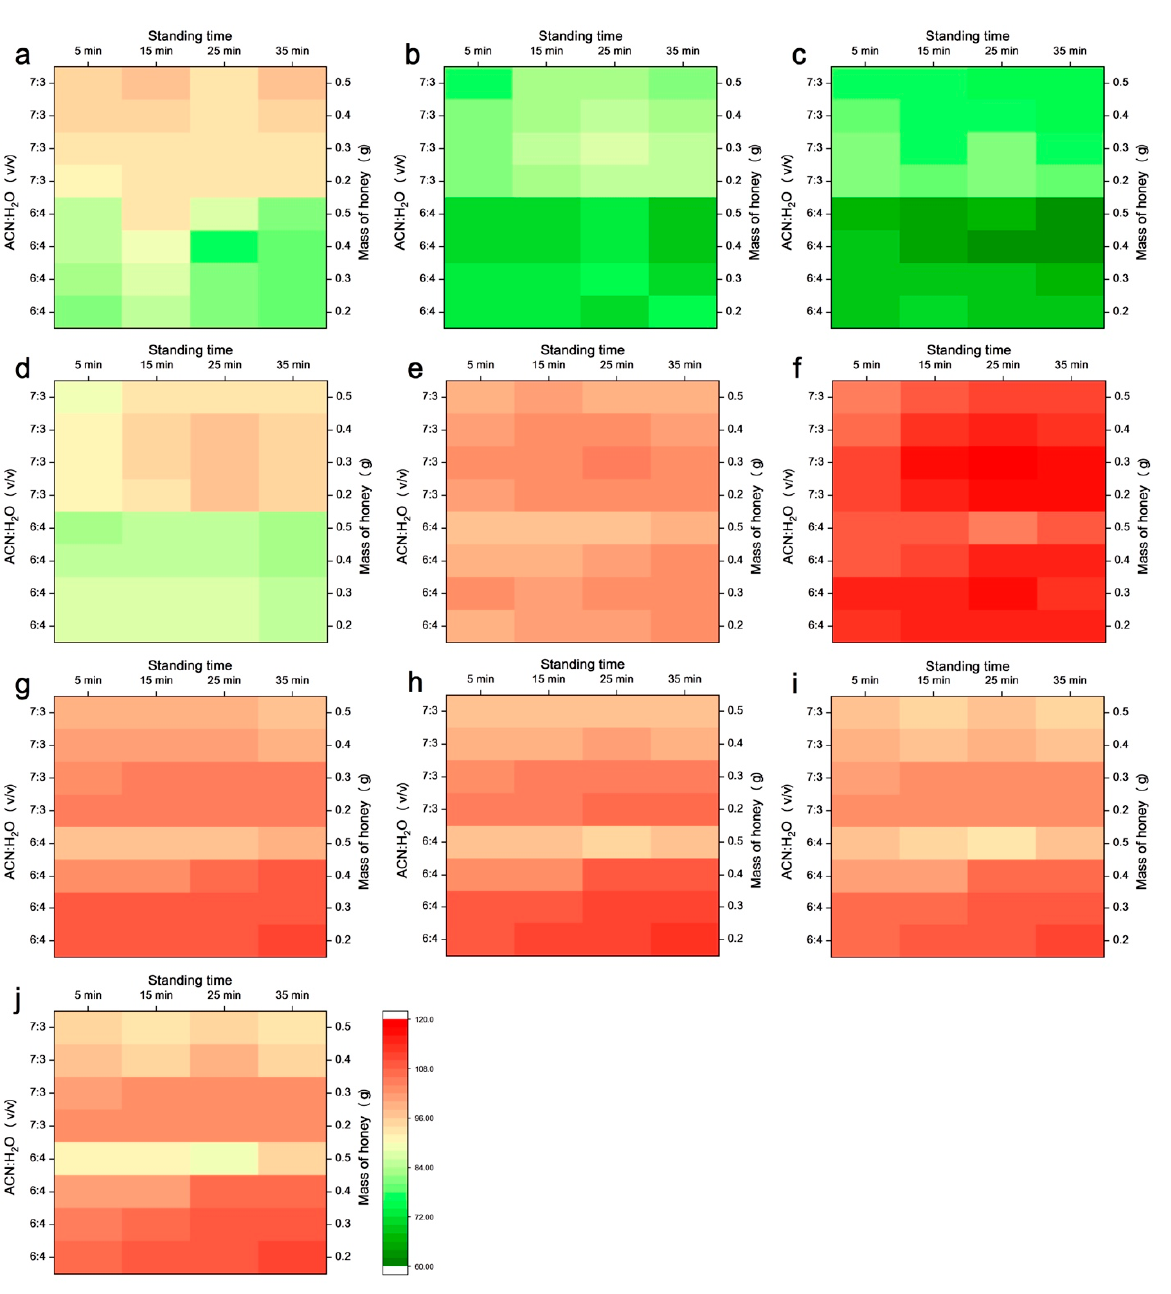
Figure 2. Effects of the ratio of ACN-H 2 O (6:4 and 7:3, v / v ), mass of honey sample (0.2, 0.3, 0.4, and 0.5 g), and standing time (5, 15, 25, and 35 min) on the calculated recovery (%) of analytes. ( a ) 5-hydroxymethylfurfural; ( b ) protocatechuic acid; ( c ) pinocembrin; ( d ) caffeic acid; ( e ) 3,4-dimethox- ycinnamic acid; ( f ) quercetin; ( g ) apigenin; ( h ) kaempferol; ( i ) chrysin; ( j ) galangin.